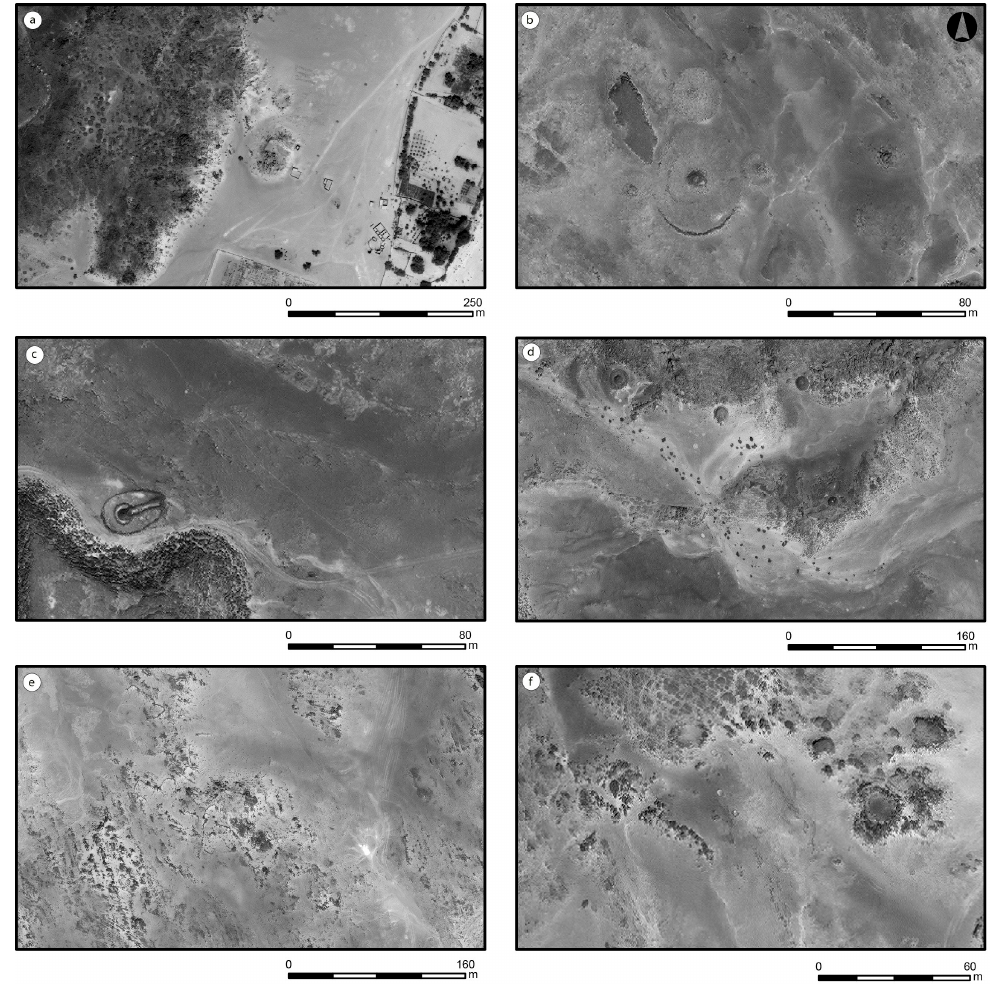
Figure 9. Selected examples of anthropogenic features recorded in the study area. ( a ) Garamantian necropolis and hilltop qasr; ( b – d ) different stone cairns from the Late/Final Pastoral period; ( e ) enigmatic stone enclosures; ( f ) Tuareg campsite (panchromatic satellite imagery courtesy of the DigitalGlobe Foundation).